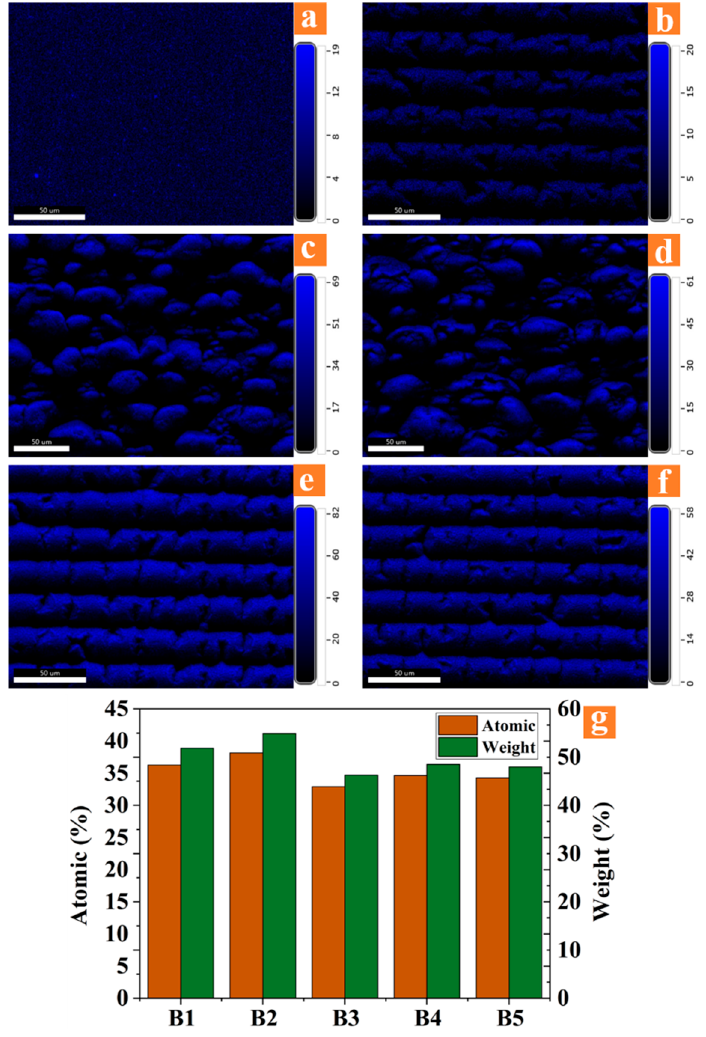
Figure 3. ( a ) Oxygen distribution on the polished surface; ( b – f ) oxygen distribution on the surface of B1–B5. ( g ) The normalized atomic percentage and mass percentage of oxygen on the surface of B1–B5.